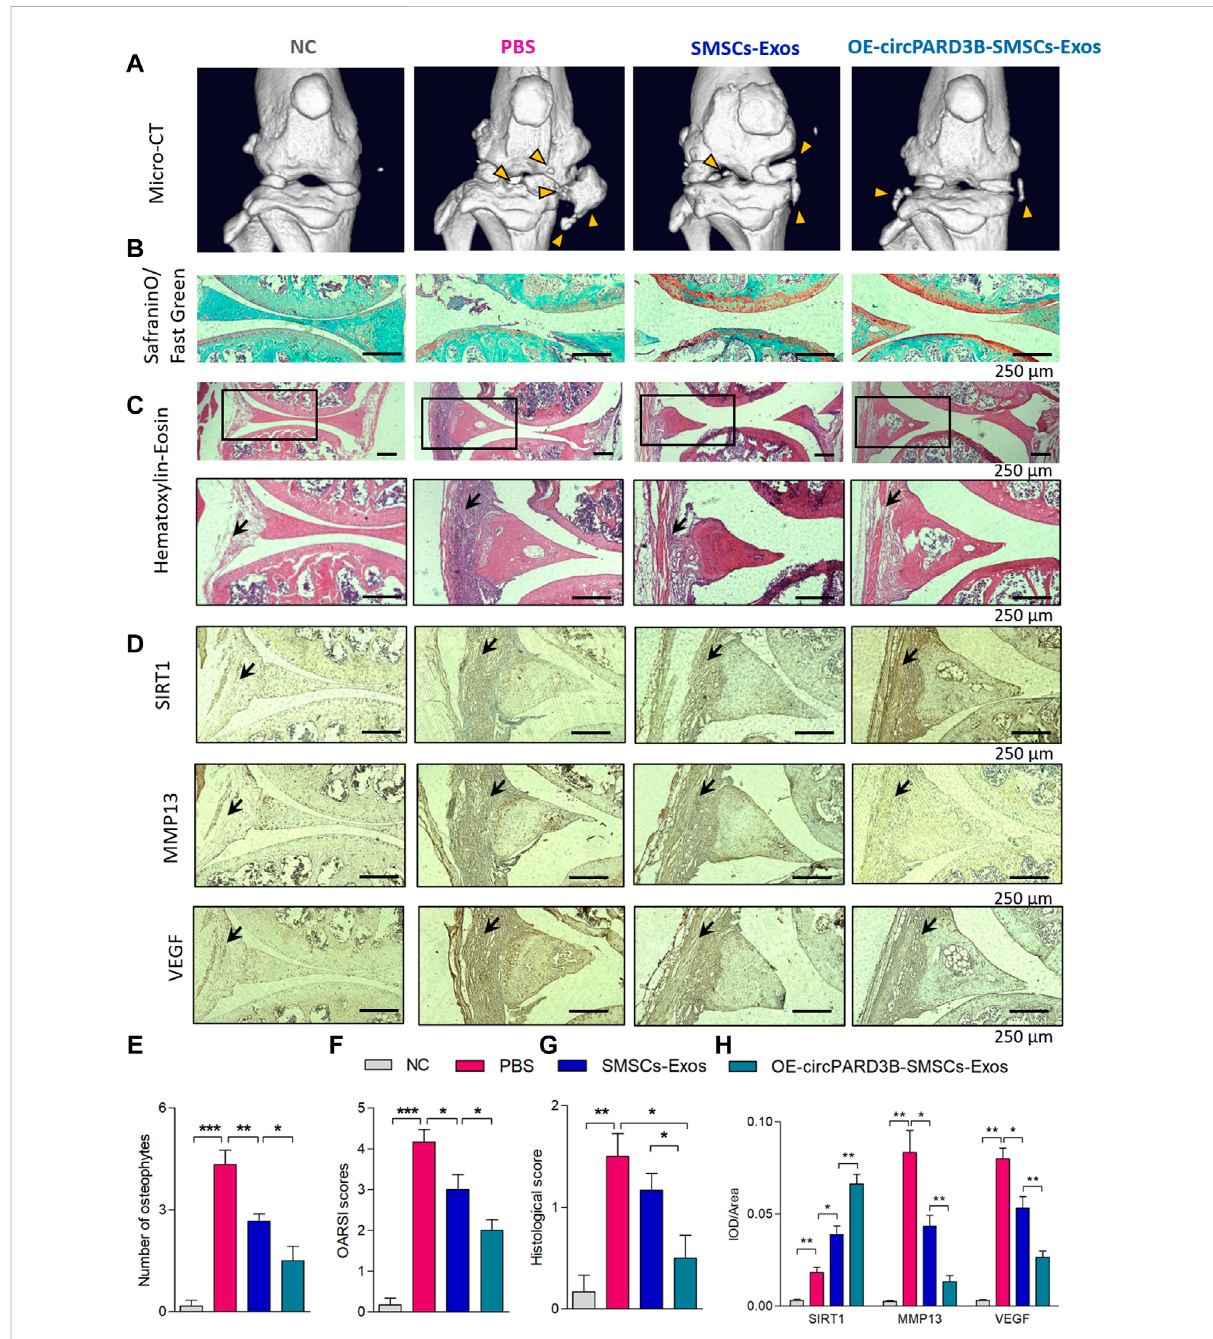
FIGURE 6 Injection of OE-circPARD3B-SMSCs-sEV alleviate the progression of arthritis in collagenase-induced OA mouse model. (A) Representative micro-CT images of knee joints showing the abnormal growth of osteophytes (yellow arrow). (B) Representative images of Safranin O/Fast Green staining of knee cartilage from mice. (C) Representative imagesof HE staining analysisof knee joints from mice. After inducedby OA, mice exhibited the mild in fl ammatory in fi ltration along with the synovial hyperplasia in the synovial tissues. Joint in fl ammation was reduced in the SMSCs-sEV group in contrast to the OA control group with statistical signi fi cance, especially in OE-circPARD3B-SMSCs-sEV group in contrast to BMSCs-sEV group. (D) IHC staining of SIRT1, VEGF and MMP13 were respectively demonstrated. We observed strengthened VEGF/MMP13 staining in synovial tissues of the OA control group in contrast to NC mice. OE-circPARD3B-SMSCs-sEV or SMSCs-sEV treated OA group revealed stregthened SIRT1 and weakened VEGF/MMP13 staining intensity in synovial tissues in contrast to the OA control mice, especially obvious in OE-circPARD3B- SMSCs-sEV group in contrast to that in the SMSCs-sEV group. (E) Quanti fi cation of images with 3D reconstruction by counting the number of osteophytes. (F) OARSI scoring to assess the histological changes of knee cartilage. (G) Histological assessment scores were shown. (H) Integrated optical density (IOD) values ofimmunostaining wereshown inaverage.Scale bars= 250 µm. Data aredescribed withmean ± S.E.M. n=6; * p < 0.05, ** p < 0.01, *** p < 0.001. NC = PBS treated normal control mice. OA control group = PBS treated OA